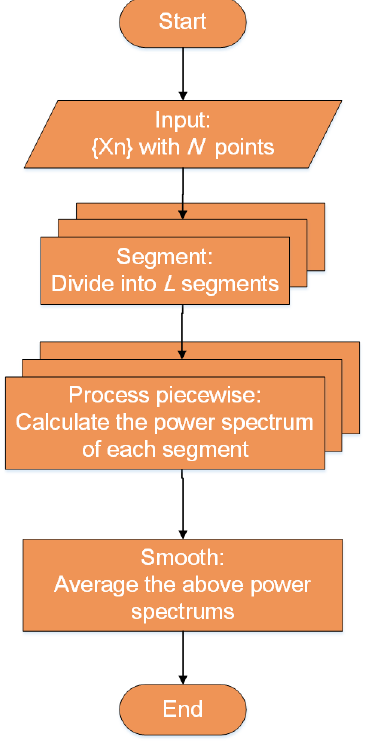
Figure 3. The algorithm model of the Bartlett